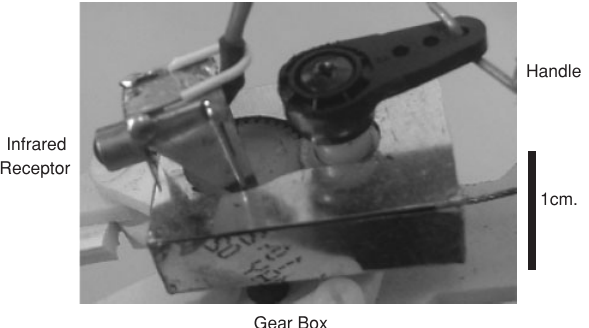
Figure 4 Detail of the sensor mount on top of the “hand”. It is a pull-to-rotate gear box that rotates the infrared sensor, parallel to the